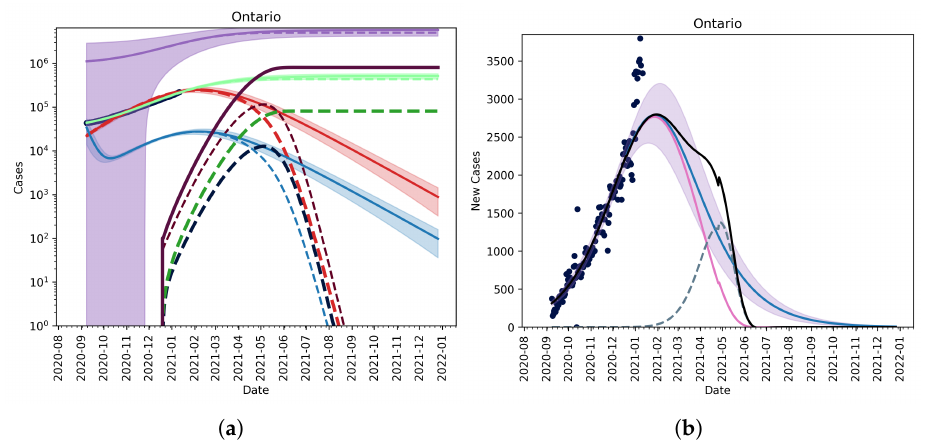
Figure 6. Model fit assuming the period over Christmas to be anomalous, including vaccination and relaxation. Vaccination assumes that 10% of the population is vaccinated by 31 March 2021 and that 75% of the population is inoculated by the end of 2021. Relaxation allows for NPIs to be lifted on 1 May 2021. ( Left column , ( a )) The active and cumulative cases are shown given the model with (dashed lines) and without (solid lines) the mutant strain (dashed lines). Active mild and severe wild-type infected cases are shown in red and blue. Active and severe mutant infected populations are shown in dark red and dark blue. The cumulative known and total cases of the wild-type and mutant strains are shown in light and dark green, and light and dark purple, respectively. ( Right column , ( b )) The new reported cases per day given the model with (wild-type—solid pink line, mutant—dashed blue line, and total—solid black line) and without (wild-type—solid blue line) the mutant. Ontario reported case data, from September 2020 to December 2020, are also shown